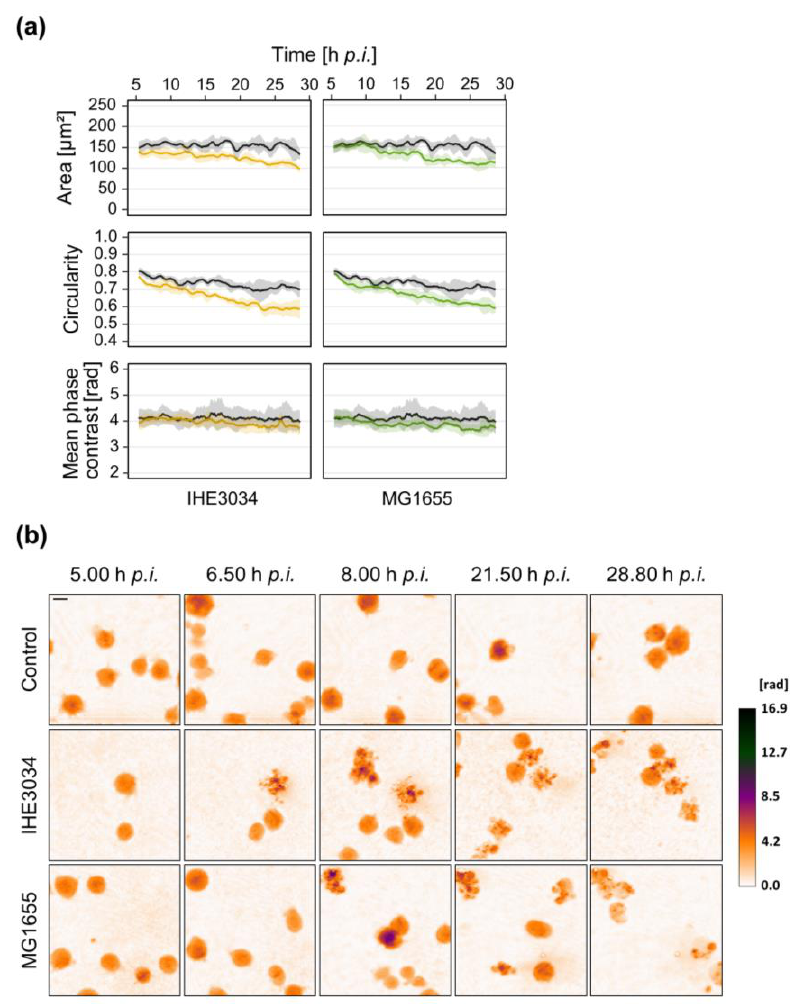
Figure 6. Morphological changes of Jurkat cells infected with E. coli strains IHE3034 or MG1655. Jurkat cells were infected with E. coli strains IHE3034 or MG1655 (MOI 10). After 4 h, bacteria were removed by centrifugation and Gentamicin treatment (50 µg/mL) to prevent overgrowth. Mock-infected cells served as control. DHM measurement was started at 5 h p.i. to monitor cellular morphological changes. ( a ) DHM quantitative phase contrast images were analyzed for the average single-cell area (µm 2 ), average circularity (AU), and mean phase contrast (rad) per cell. Results represent mean (lines) ± SD (shading) of at least three independent experiments. Controls are shown in black while different colors designate the individual strains. For better visualization, curves were smoothed using moving averages with a window size of 15 measuring points. ( b ) Representative color-coded phase contrast images of Jurkat cells at indicated time points after infection. The scale bar corresponds to 10 μm. The calibration bar indicates phase contrast values in radian.